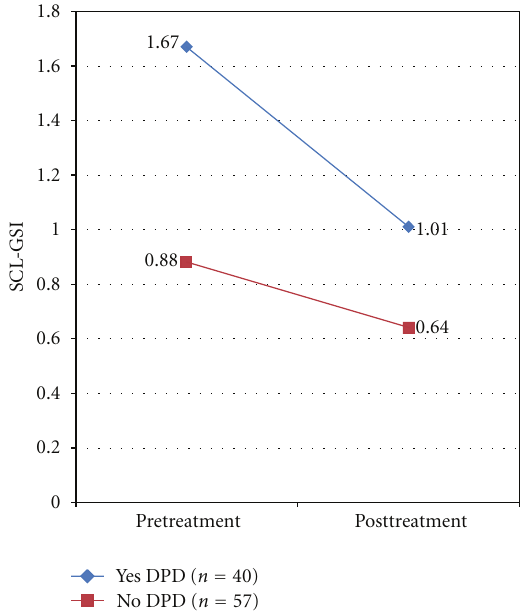
Figure 2: Changes in mean GSI scores from pre- to posttreatment between groups (DP yes, top line; DP no, bottom line). Note. SCL- GSI: Symptom Checklist-90 Global Severity